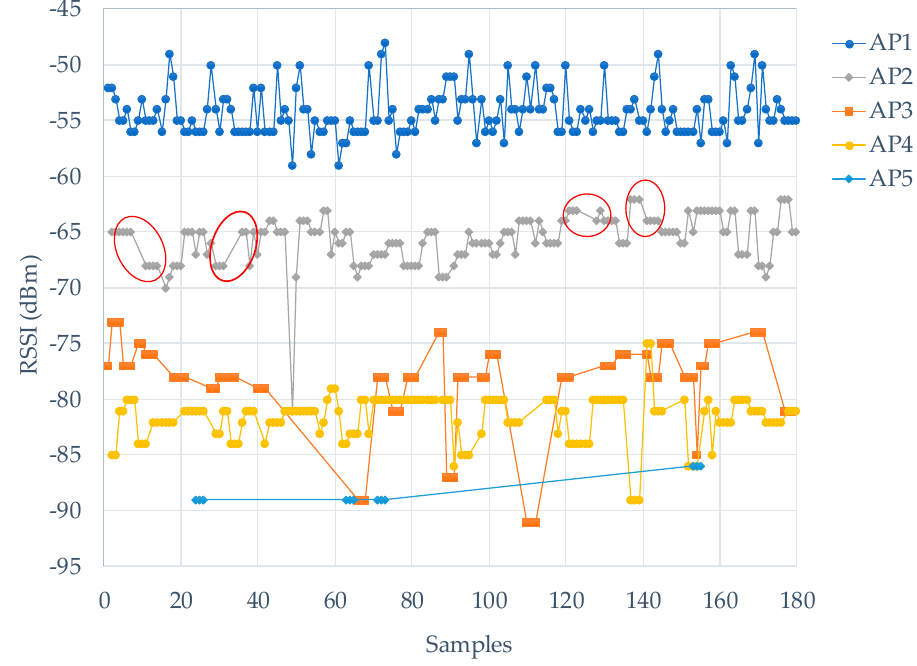
Figure 2. Detected received signal strength indicator (RSSI) sequences at a specific sampling point.